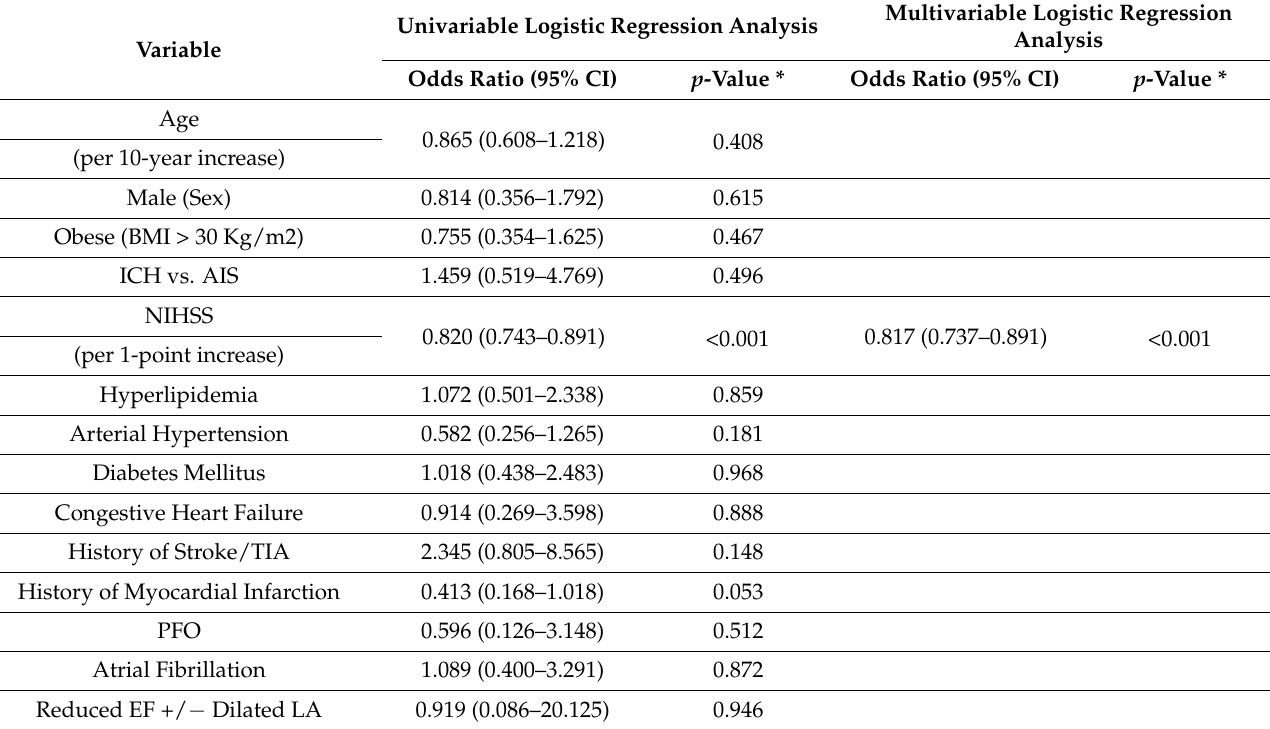
Table 3. Univariable and multivariable logistic regression analyses depicting the associations of base- line characteristics with the likelihood of excellent functional outcome (mRS-score 0–1) at 3 months among all